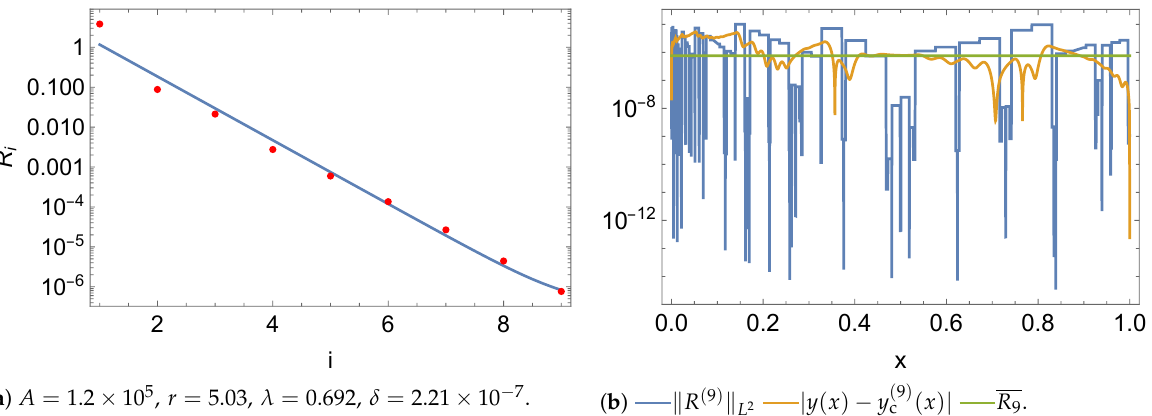
Figure 7. ( a ) Fitting the upper bound (24) with the set R . ( b ) Visualization of the residual, absolute local approximation error, and the mean value.